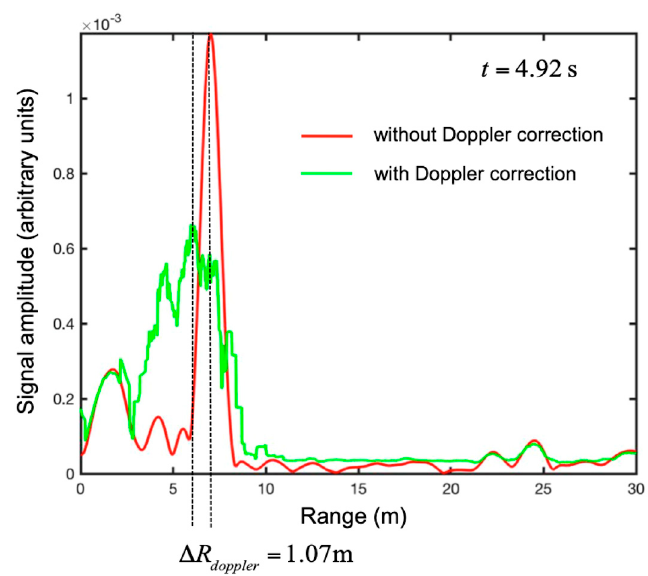
Figure 20. Maneuver 1 (i.e., take-off and rapid running away). Range plots at time t = 4.92 without the Doppler correction ( in red ) and with the Doppler correction ( in green ).